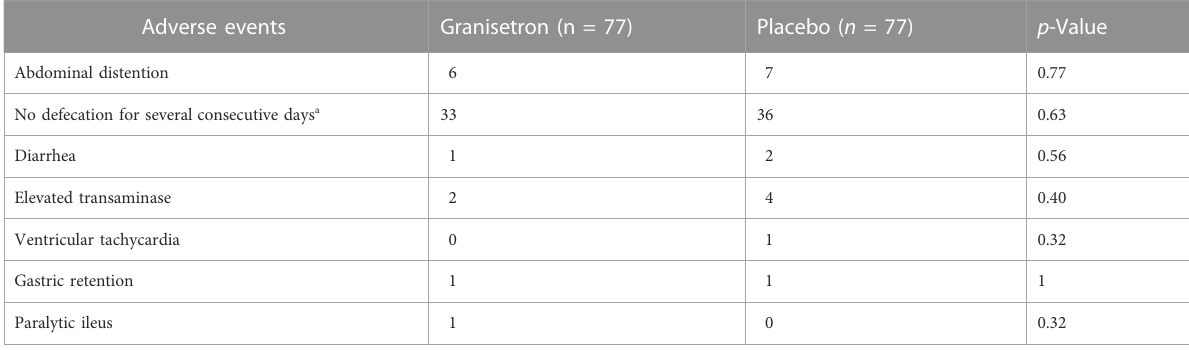
TABLE 3 Adverse